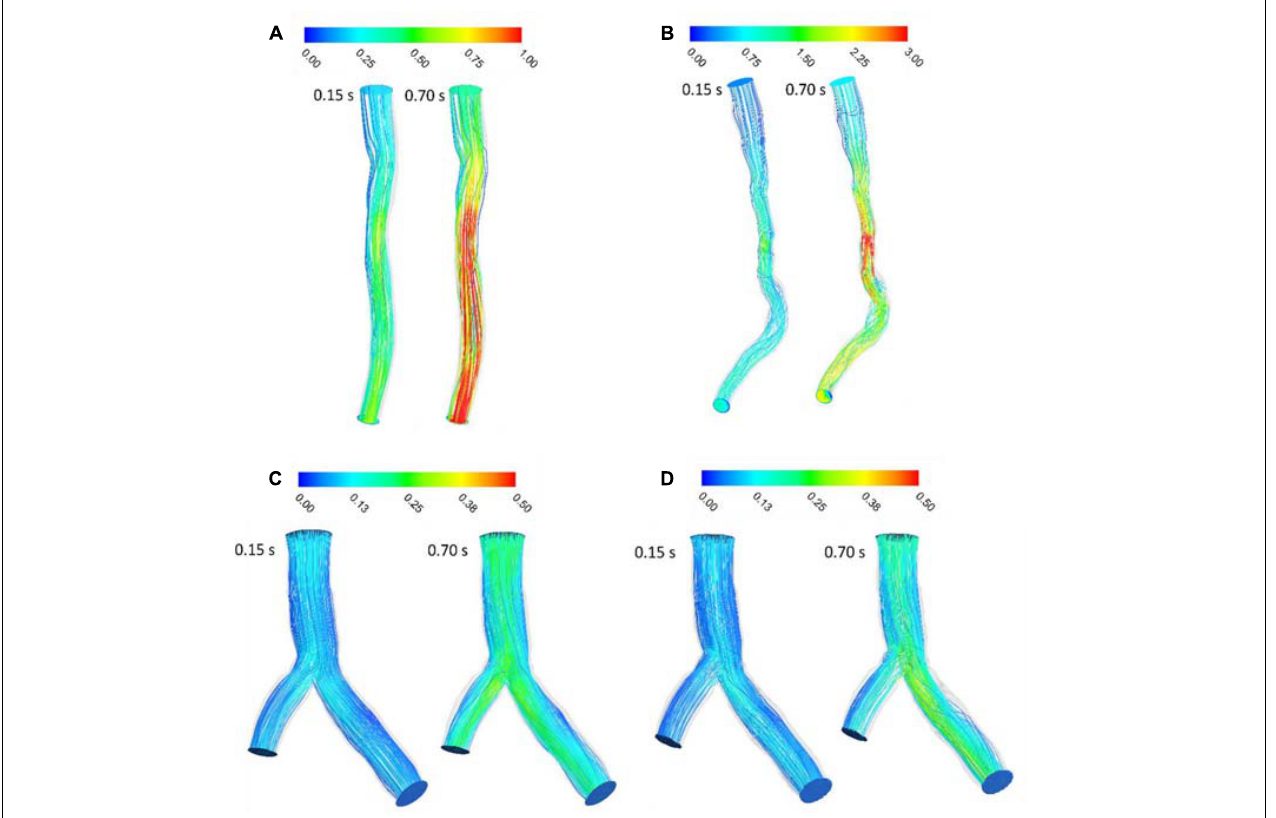
FIGURE 2 | Blood velocity pathlines (m/s) (A) for patient A and (B) for patient B (C) for patient C without stent and (D) with stent during both systole (0.15 s of pulse) and diastole (0.7 s of pulse).